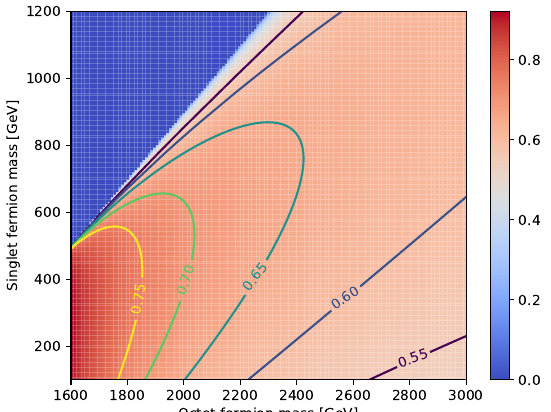
˜ Figure 8. Branching ratio of ˜ g → π 8 B for the mixed decays. The scalar masses are fixed to = 1 . 1 TeV and m = 1 . 4 TeV. The ratio of the couplings to π and π is set to 1.5, so that for m π π 3 8 3 8 heavy gluonis, the branching ratio is about 50%. For m 0 , the decay via π dominates, whereas ˜ g → 8 it is kinematically forbidden in the top left.